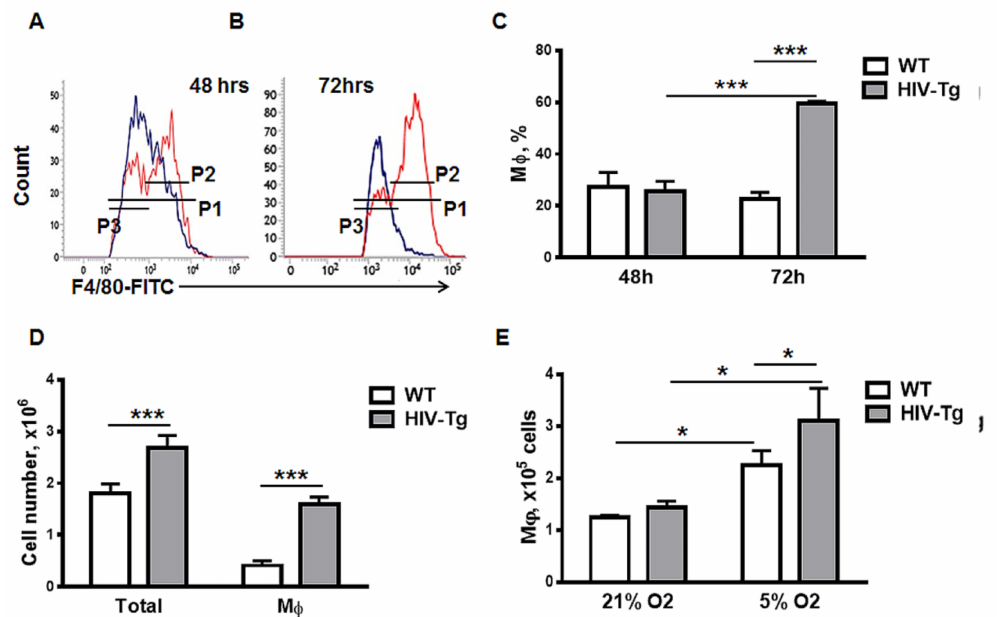
Figure 5. Resolution of macrophage infiltration into the peritoneal cavity is impaired in HIV-Tg mice at 72 h after LPS administration. ( A , B ) Representative data of flow cytometry for WT (blue) and HIV-Tg (red) macrophages at 48 (A) and 72 h (B) after LPS administration. ( C ) Quantification of peritoneal macrophages for P1 gate in WT and HIV-Tg mice at 24 h, 48 h and 72 h after LPS administration. P2 is a gate for M φ with low-level F4 / 80, P3 is a gate for M φ with a high level of F4 / 80. Results are shown as percent of peritoneal cell population. n = 3. ( D ) Total number of peritoneal cells and macrophages in WT and HIV-Tg mice at 48 h and 72 h after LPS administration. Results are shown as cell number. n = 3. ( E ) Proliferation of peritoneal macrophages isolated from WT and HIV-Tg mice at 5% and 21% oxygen in vitro. n = 3. Mean and SD are shown. * p < 0.05, *** p <